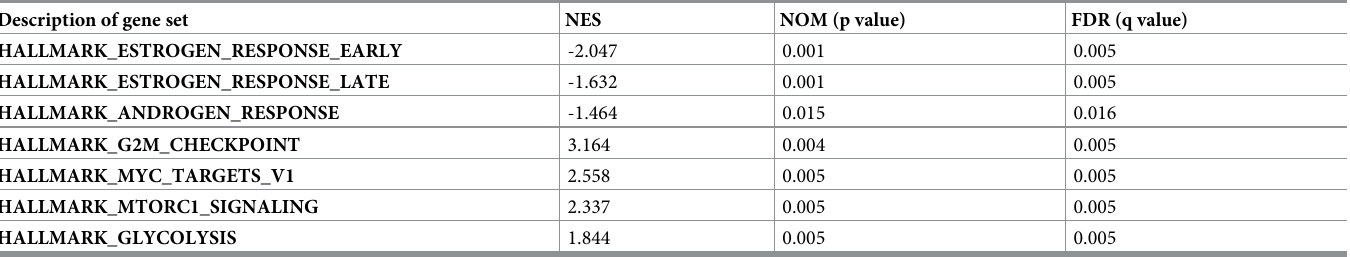
Table 5. Gene sets which were significantly enriched.